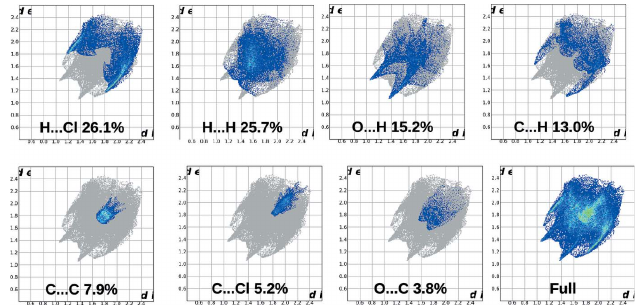
Figure 6 Two-dimensional fingerprints